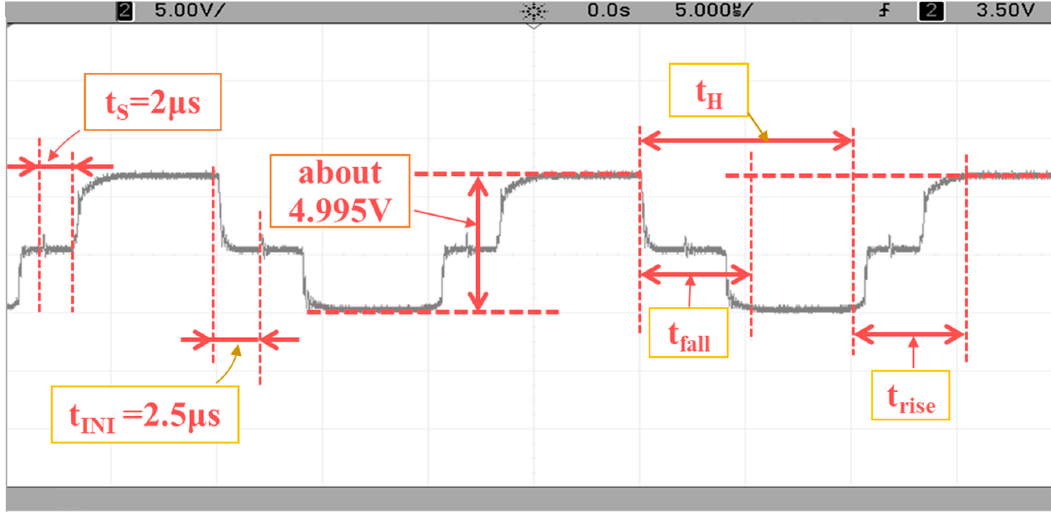
Figure 9. The measured output waveform of the fabricated 10-bit column